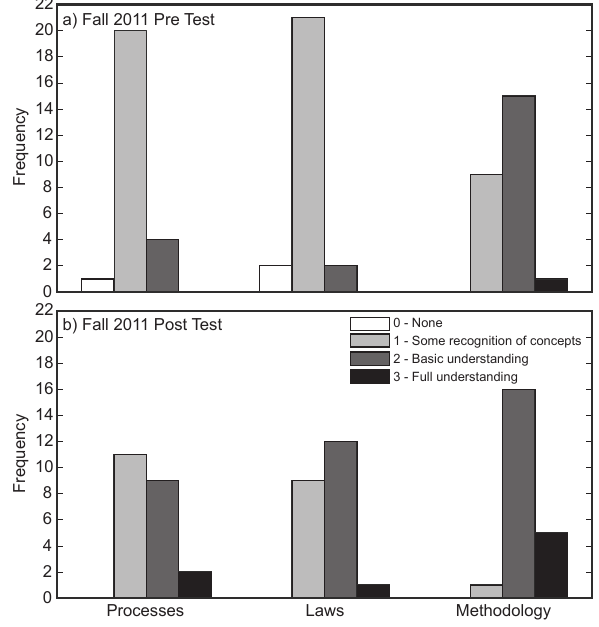
Fig. 1. Results of pre- (a) and post- (b)